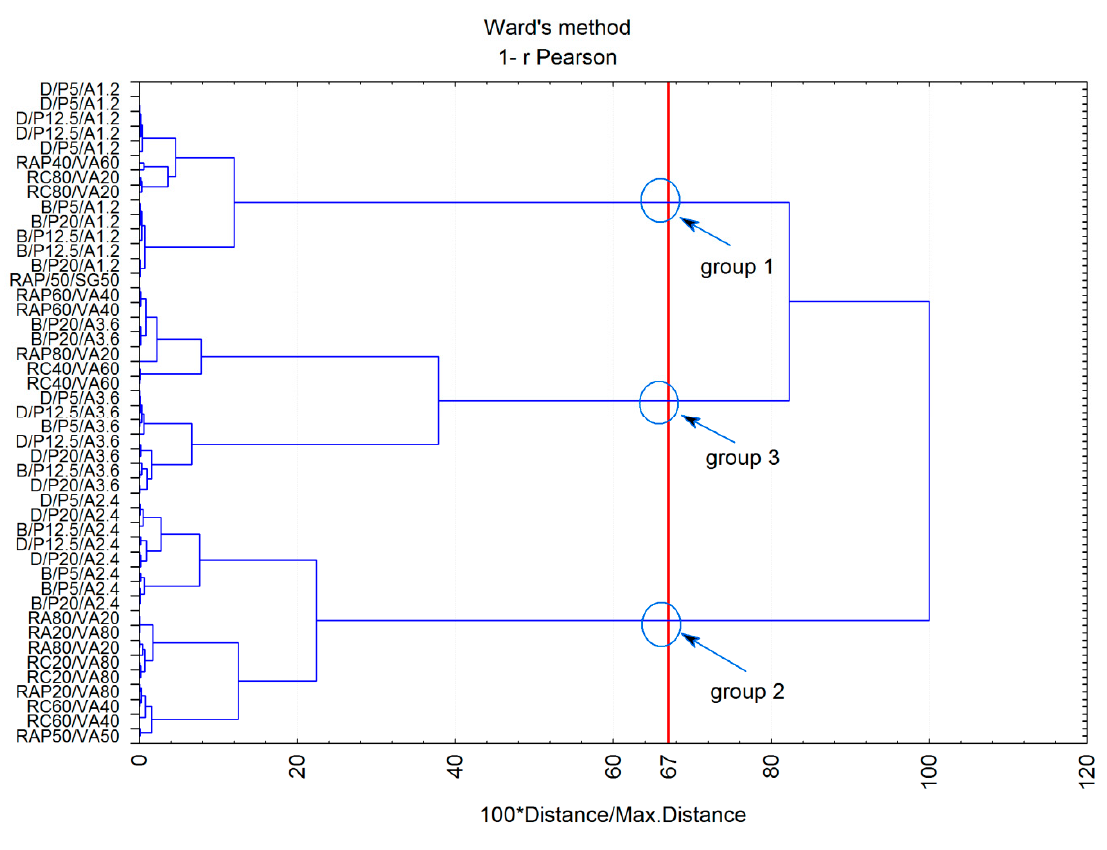
Figure 3. Dendrogram showing similarities between recycled MCAS mixes with waste materials.